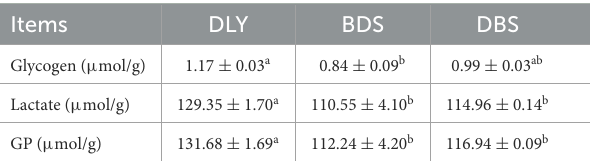
TABLE 4 Comparison of GP in longissimus dorsi muscles of DLY, BDS, and DBS.